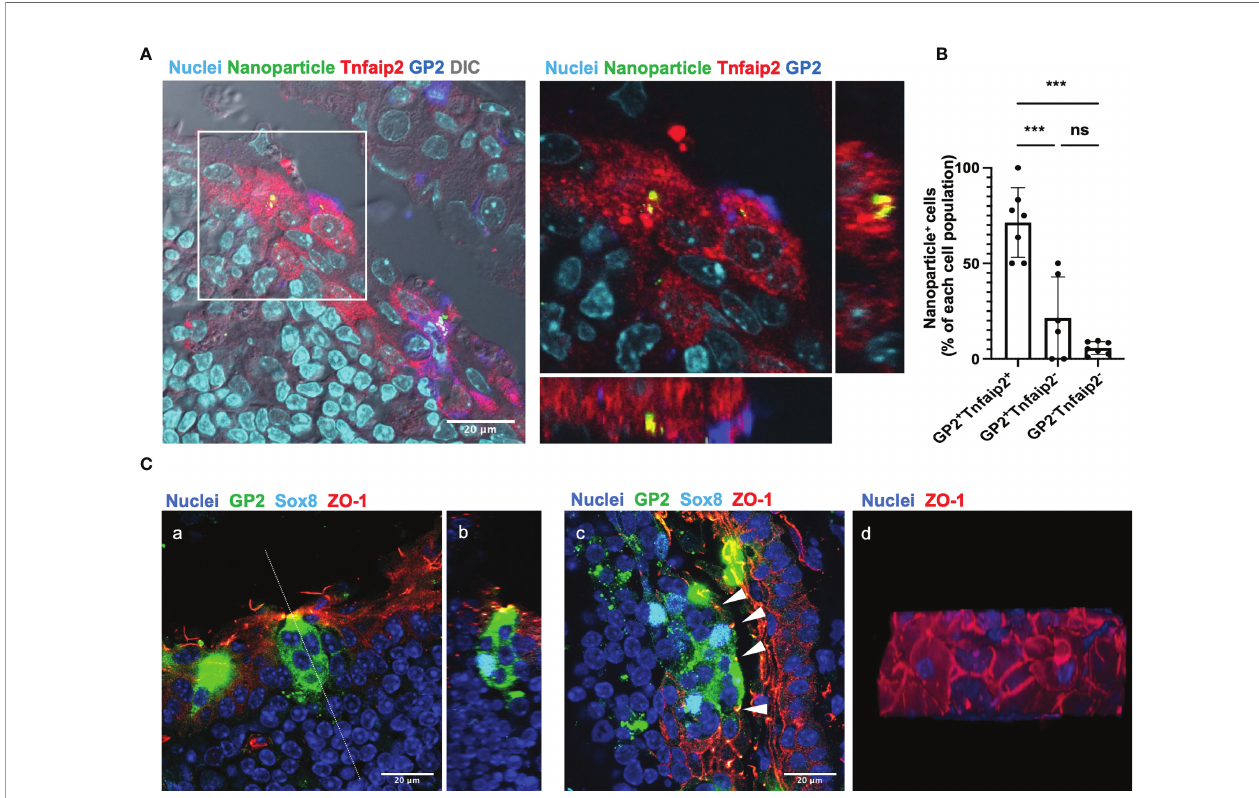
FIGURE 3 | GP2 + Tnfaip2 + cells take up the fl uorescent nanoparticles instilled by eye drop. (A) GP2 (blue) Tnfaip2 (red) -positive cells take up 200 nm nanoparticles (green) dropped into the eyes of BALB/c mice under anesthesia as described in the method. The right panel shows a higher magni fi cation of the area outlined in the left panel. Representative images of those obtained from at least 3 animals are shown. (B) Quanti fi cation data of the uptake ability of GP2 + Tnfaip2 + cells, GP2 + Tnfaip2 - cells, and GP2 - Tnfaip2 - cells. Data represent the percentage of bead + cells in each cell population. Bars represent the mean ± standard deviation. ***P < 0.001, ns not signi fi cant (Kruskal-Wallis test, n = 4 animals). (C) Immuno fl uorescence analysis of thick cryosections (40 µm) shows the expression of ZO-1 (red) in the outer layer of the TALT FAE. Green is GP2 and cyan is Sox8. Panel b shows a sliced image along the dotted line in panel a, reconstructed from consecutive confocal microscope images. Arrowheads in panel c show the tight junction in FAE of TALT. Panel d shows a top view of the FAE of the reconstructed 3D image. Representative images of those obtained from at least 4 animals are shown. Nuclei were stained with Hoechst 33342 (blue). Bars: 20 m